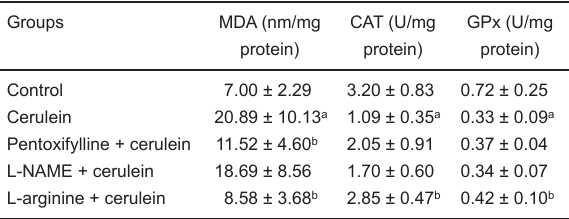
Table 2. Malondialdehyde and antioxidant enzyme activity levels of cerulein-treated rats.